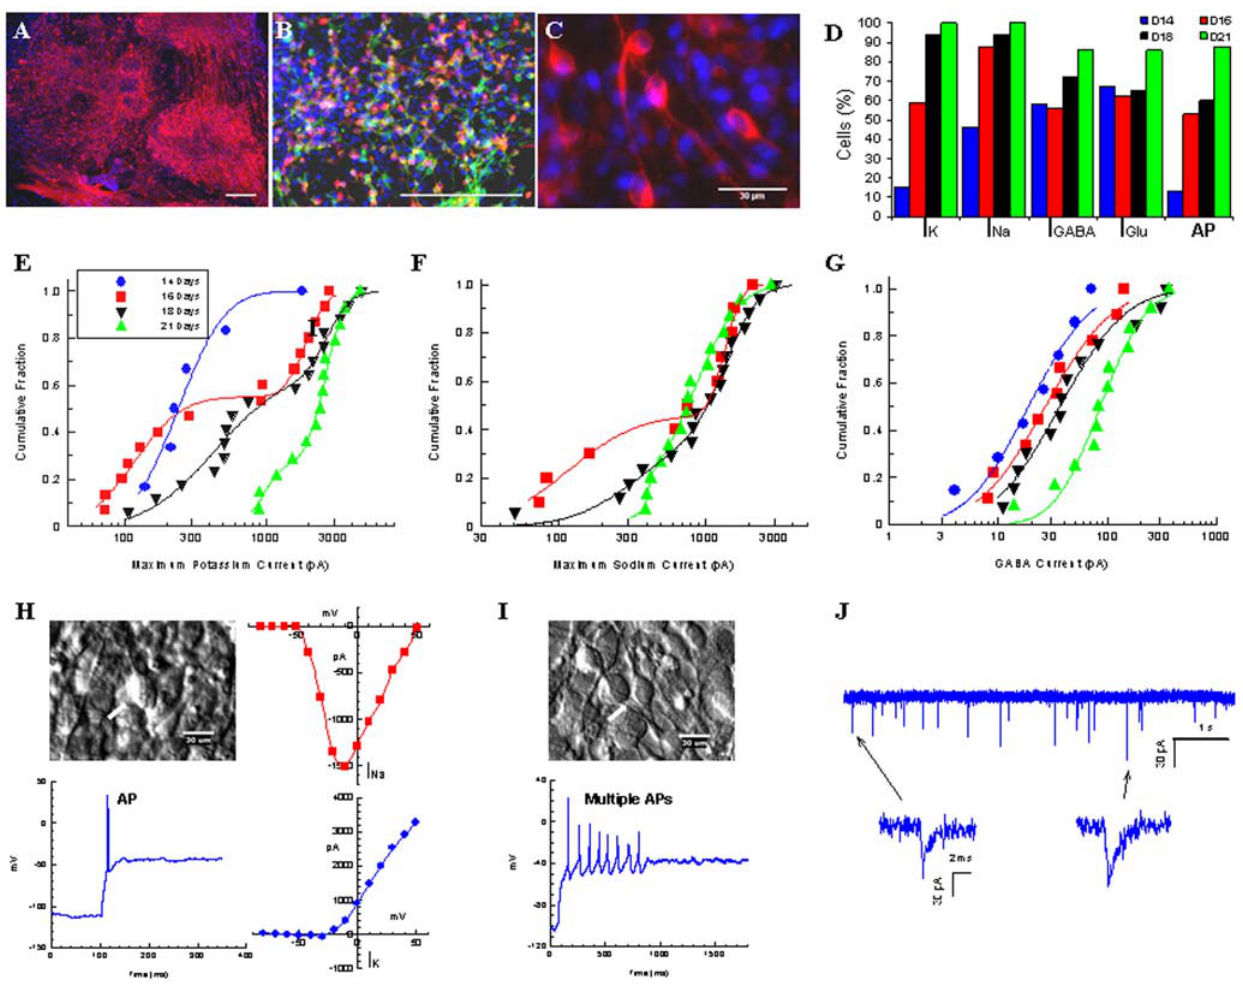
Figure 6. Electrophysiological analysis BG01V2-derived cultures differentiated by SPIE. Representative images of TH (A), and TH and MAP2 (B) immunocytochemistry of cultures differentiated for 21 days by SPIE (Scale bar 200 m m). Illustration of the cellular morphology of TH- immunoreactive neurons (C). Bar graph showing percentages of cells eliciting sodium (I NA ), potassium (I K ), GABA-evoked (I GABA ), and Glutamate- evoked (I Glu ) currents and percentage of cells capable of generating action potentials (AP) after 14 (blue), 16 (red), 18 (black) and 21 (green) days. Representation of cumulative log-normal distribution of maximum potassium currents (E), sodium currents (F), and GABA currents (G) over time. Hoffman modulation contrast image of a cells showing electrical excitability as indicated by strong inward sodium currents (red curve) and outward potassium currents (blue curve) under voltage clamp at day 21 of differentiation (H). In current clamp mode, this cell exhibited a strong AP which was obtained by a 90 pA current step from a membrane potential of 2 112 mV with an after hyperpolarization (H). An example of a neuron capable of generating multiple APs after 18 days of differentiation (I). Spontaneous, miniature postsynaptic currents recorded from a cell at day 21 of differentiation (J).